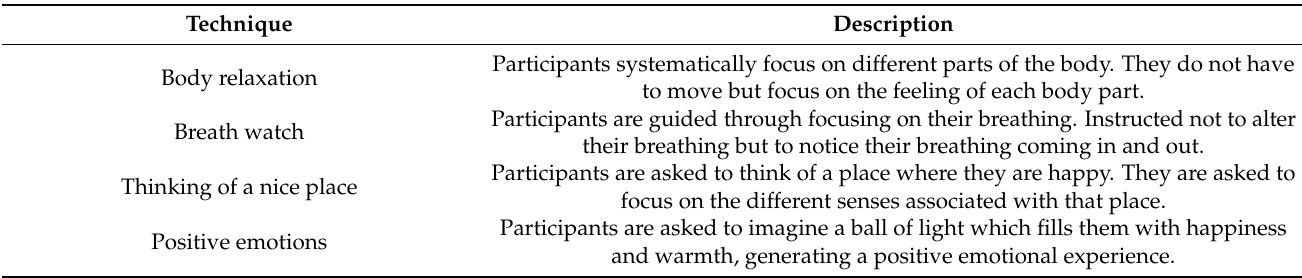
Table 2. Description of the four relaxation and mindfulness